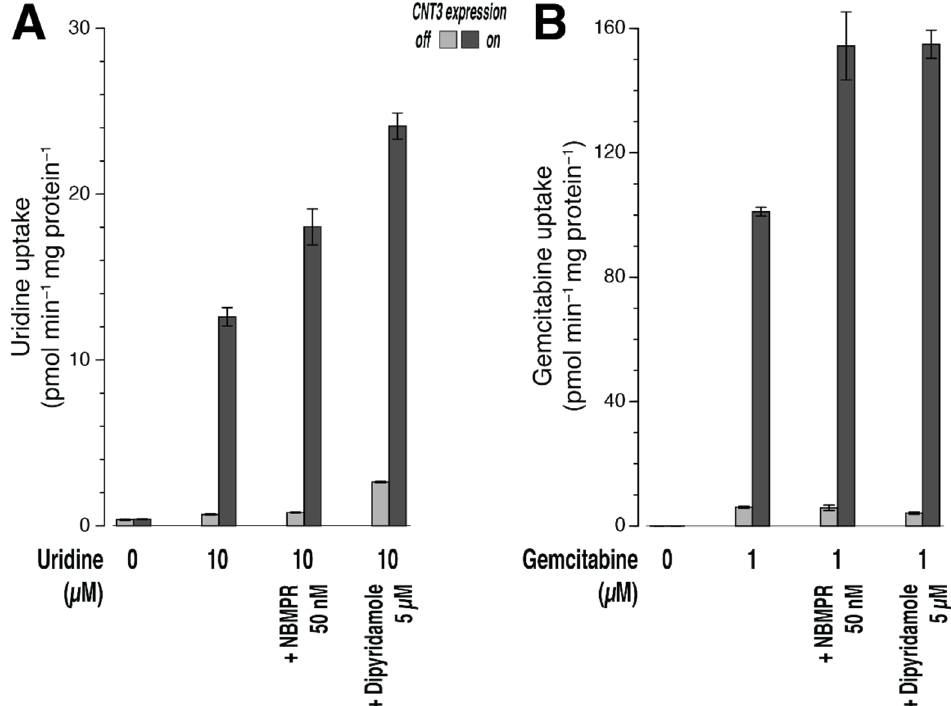
Figure 1. Uptake of uridine (A) or gemcitabine (B) into 293 cells with or without expression of CNT3. Stably transfected 293 cells with (on) or without (off) expression of CNT3 from humans were incubated at 37 °C with 10 µM uridine (10 min) or 1.0 µM gemcitabine (5 min) (± inhibitors as indicated) in uptake buffer or merely with uptake buffer, washed, and lysed with methanol. The nucleoside content of cell lysates ( n = 3) was determined by LC–MS/MS.